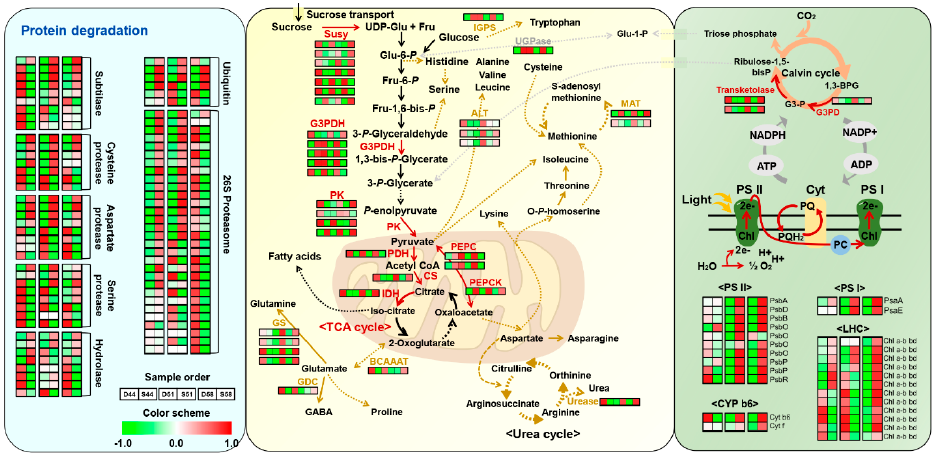
Figure 7. Schematic mapping of identified proteins to visualize the overall representative changes when comparison carried out Daewon versus Saedanbaek varieties during seed filling stages. The abundance differences of each protein are depicted by red and green color scheme. Abbreviations used: SuSy (sucrose synthase); GAPDH (glyceraldehyde 3-phosphate dehydrogenase); PK (pyruvate kinase); PDH (pyruvate dehydrogenase); CS (citrate synthase); IDH (isocitrate dehydrogenase); PEPC (phosphoenolpyruvate carboxylase); PEPCK (phosphoenolpyruvate carboxylkinase); IGPS (indole-3-glycerol phosphate synthase); UGPase (UTP-glucose pyrophosphorylase); ALT (alanine transaminase); MAT (methionine adenosyltransferase); BCAAT (branched-chain amino acid